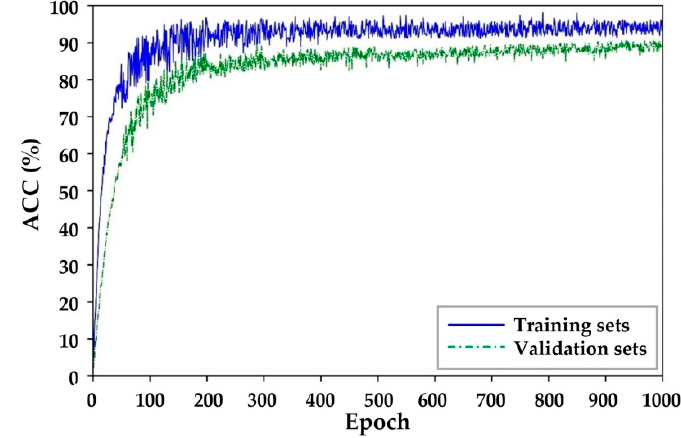
Figure 10. ACCs of training and validation sets with 0.001 learning rate.